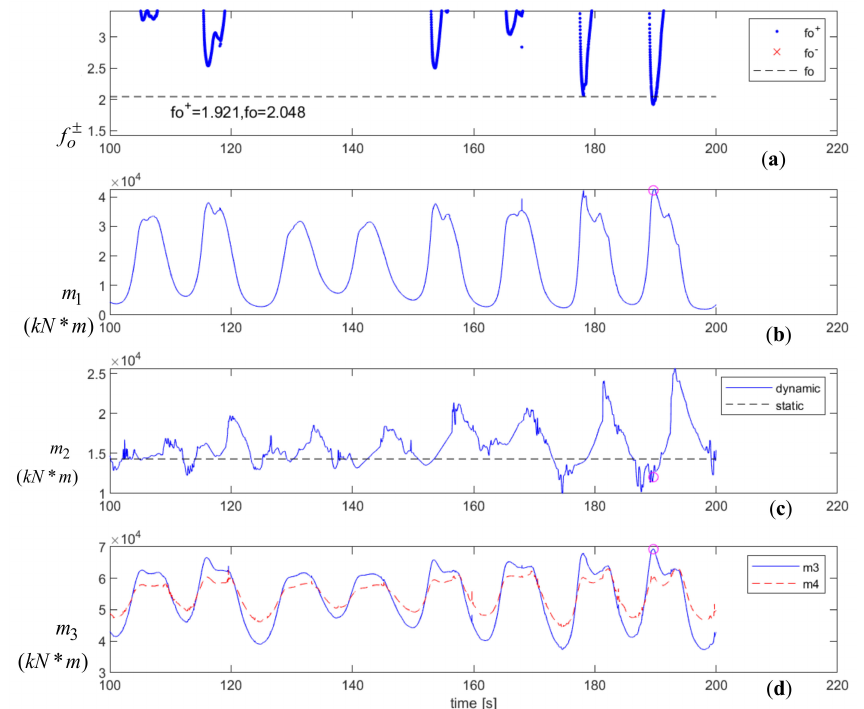
Figure 13. Comparisons of time histories of the safety factors against overturning and their moments for case 4. ( a ) The safety factors against overturning among f o + ( . ), f o − ( × ) and f o (—); ( b ) The moment m 1 (—); ( c ) The moment m 2 in static (—) and in dynamic (—); ( d ) The moment m 3 (—) and the moment m 4